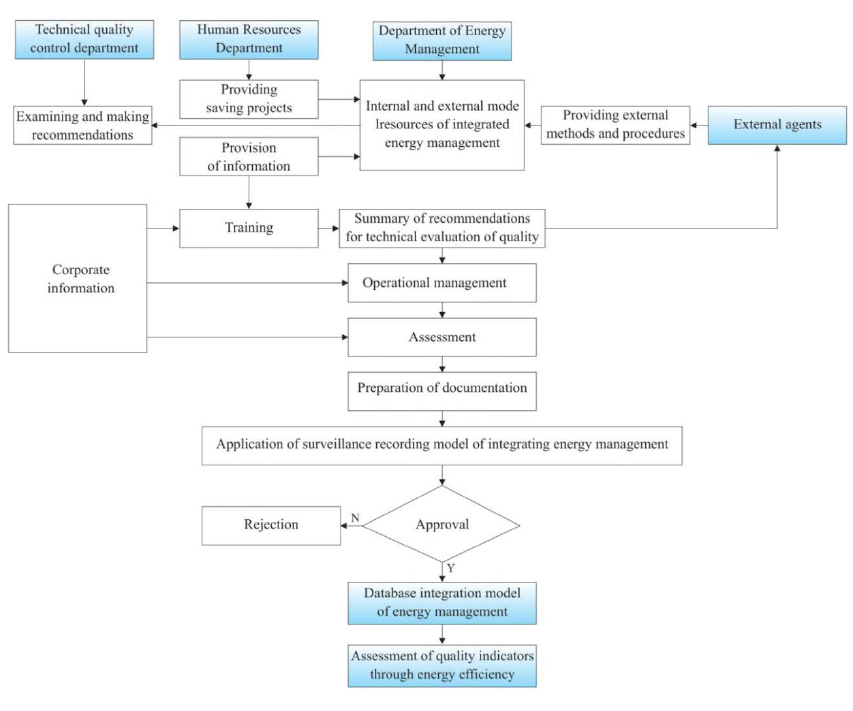
Figure 3 – Review of processes of energy integration management